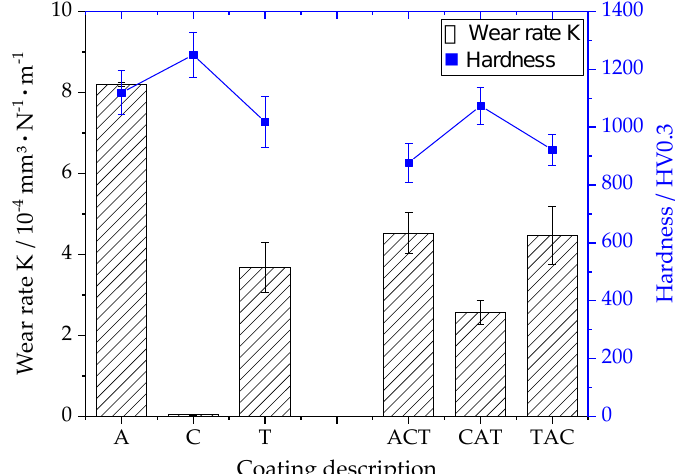
Figure 7. Hardness and sliding wear rates of plain oxide coatings (A, C, T) and composite coatings (ACT, CAT, TAC).